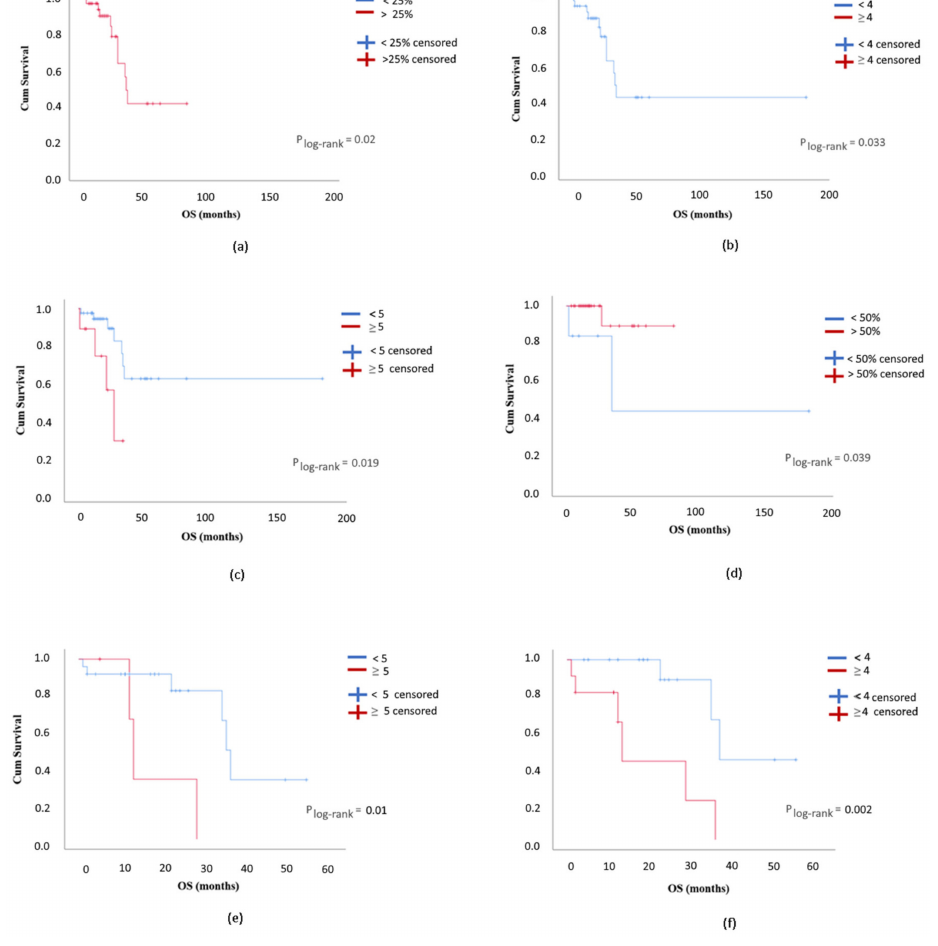
Figure 2. Overall survival (OS) of ovarian cancer patients according to ( a ) the proportion of positive stained tumor cells for E-cadherin ( < 25% vs. > 25%; n = 49); ( b ) vimentin staining score ( < 4 vs. ≥ 4; n = 49); ( c ) cytoplasm OPN staining score ( < 5 vs. ≥ 5; n = 49); ( d ) the proportion of positively stained tumor cells for nuclear OPN-c in responders ( < 50% vs. > 50%; n = 33); ( e ) membrane OPN staining score in the pegylated liposomal doxorubicin (PLD) arm ( < 5 vs. ≥ 5; n = 28); and ( f ) cytoplasm OPN-c staining score in the PLD arm ( < 4 vs. ≥ 4; n =